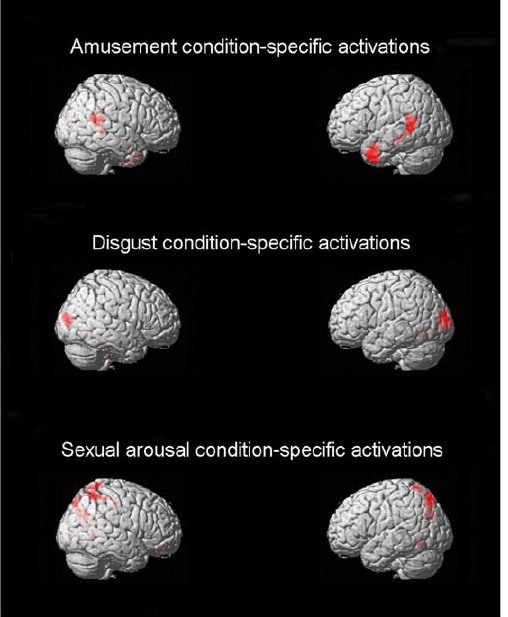
Figure 6. Three-dimensional rendered images of supra-thresh- old of activated areas for the same contrasts as Figure 5. Temporal cortical involvement is shown to be specific here to the Amusement condition, lateral occipital and fusiform areas to the Disgust condition, and superior parietal and posterior inferior temporal areas to the Sexual arousal